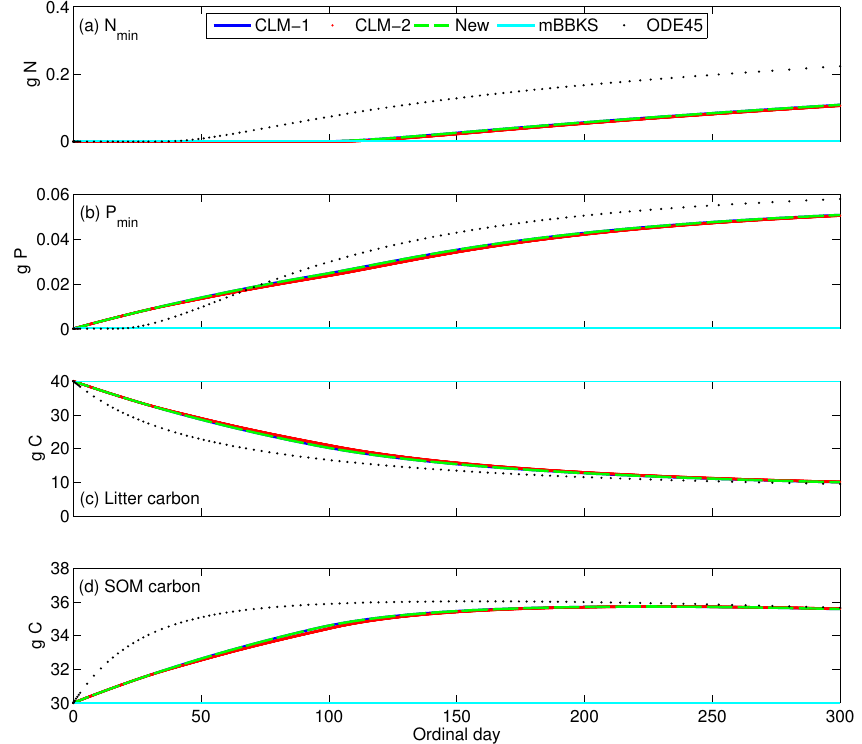
Figure 3. Simulated decomposition dynamics for Case 3 in Table 3. In all panels, the result from CLM-1 overlaps with that from our new